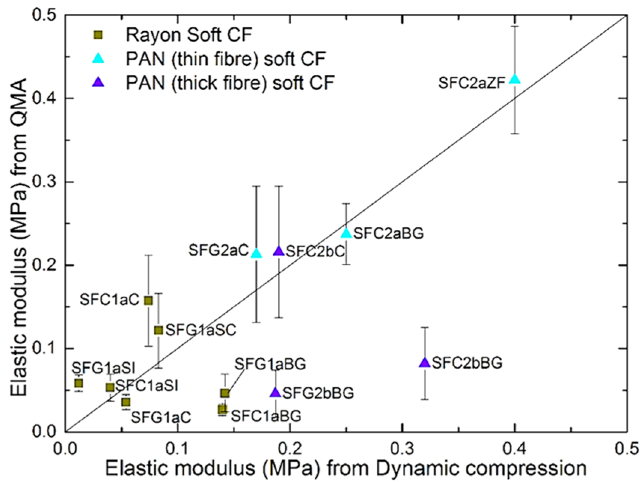
Figure 10. Comparison of modulus of elasticity values by QMA method and by dynamic compression method.